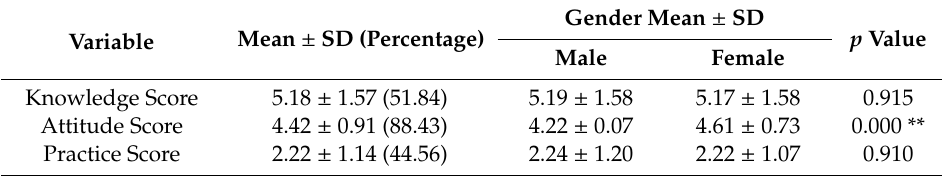
Table 2. The score of knowledge, attitude and practice on sugar-sweetened beverages (SSB).